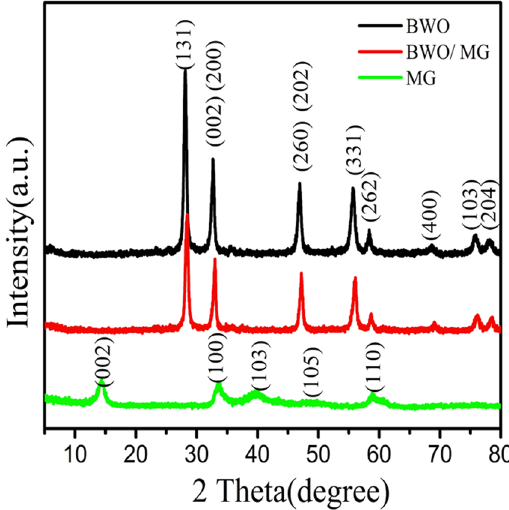
Figure 1. XRD patterns of pristine BWO, BWO/MG and MG